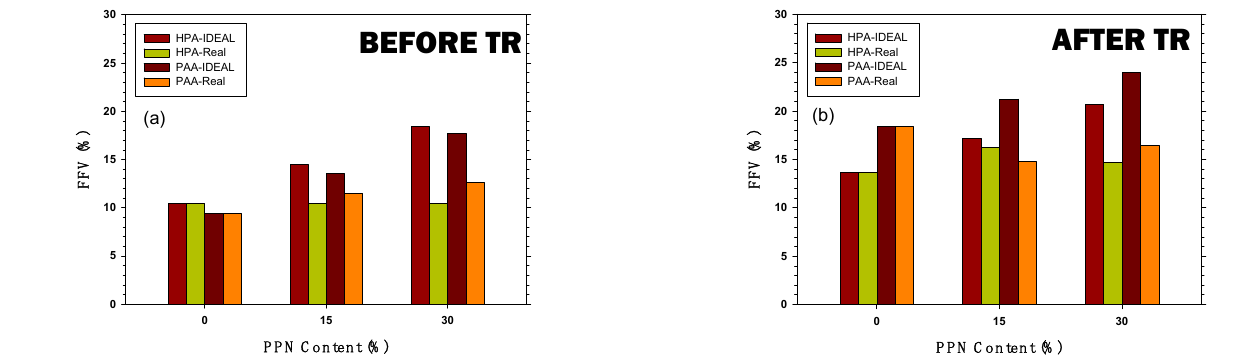
Figure 8. FFV as a function of the PPN content: ( a ) PAA and HPA before thermal rearrangement and ( b ) after thermal rearrangement. Ideal and interactive FFV calculations were explained in Equations (6) and (7).